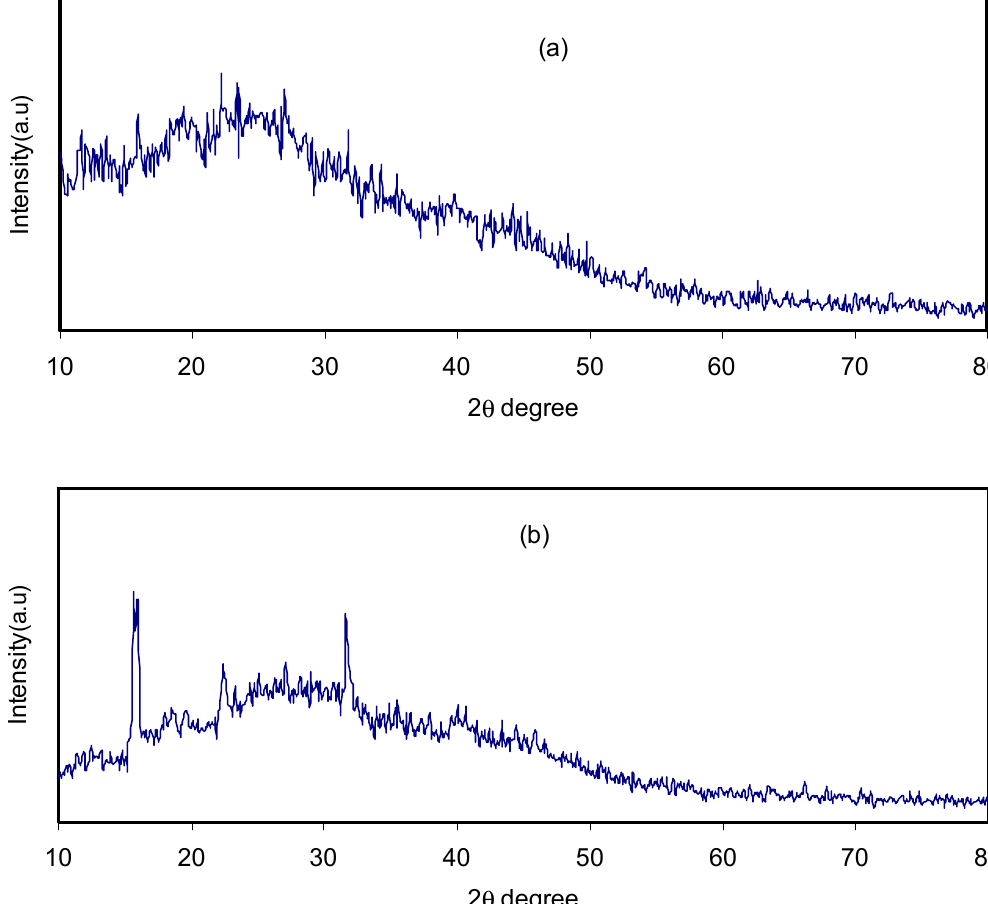
Figure 2. XRD pattern for ( a ) CSDX2 and ( b ) CSDX2 blend electrolyte samples at ambient